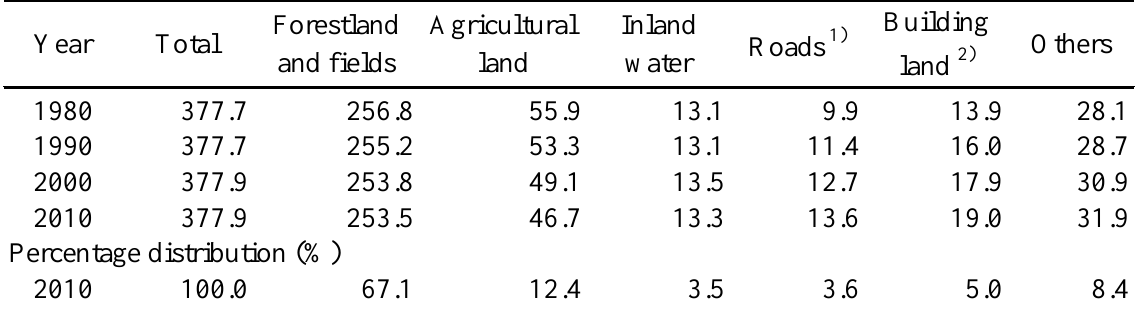
Surface Area by